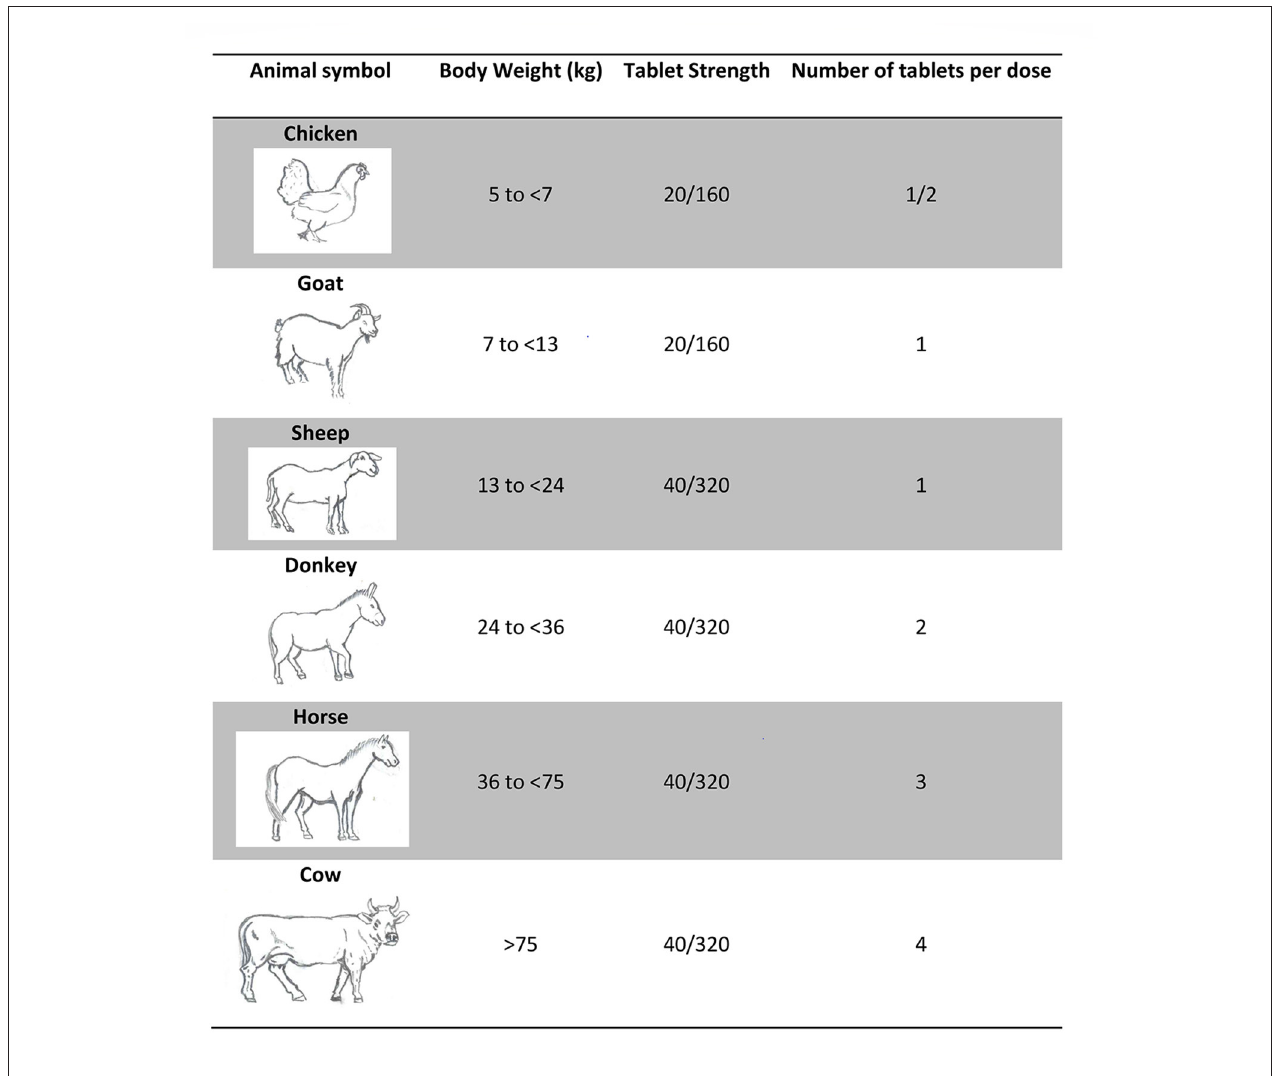
FIGURE 3 | Dihydroartemisinin-Piperaquine (DP) dosage and animal